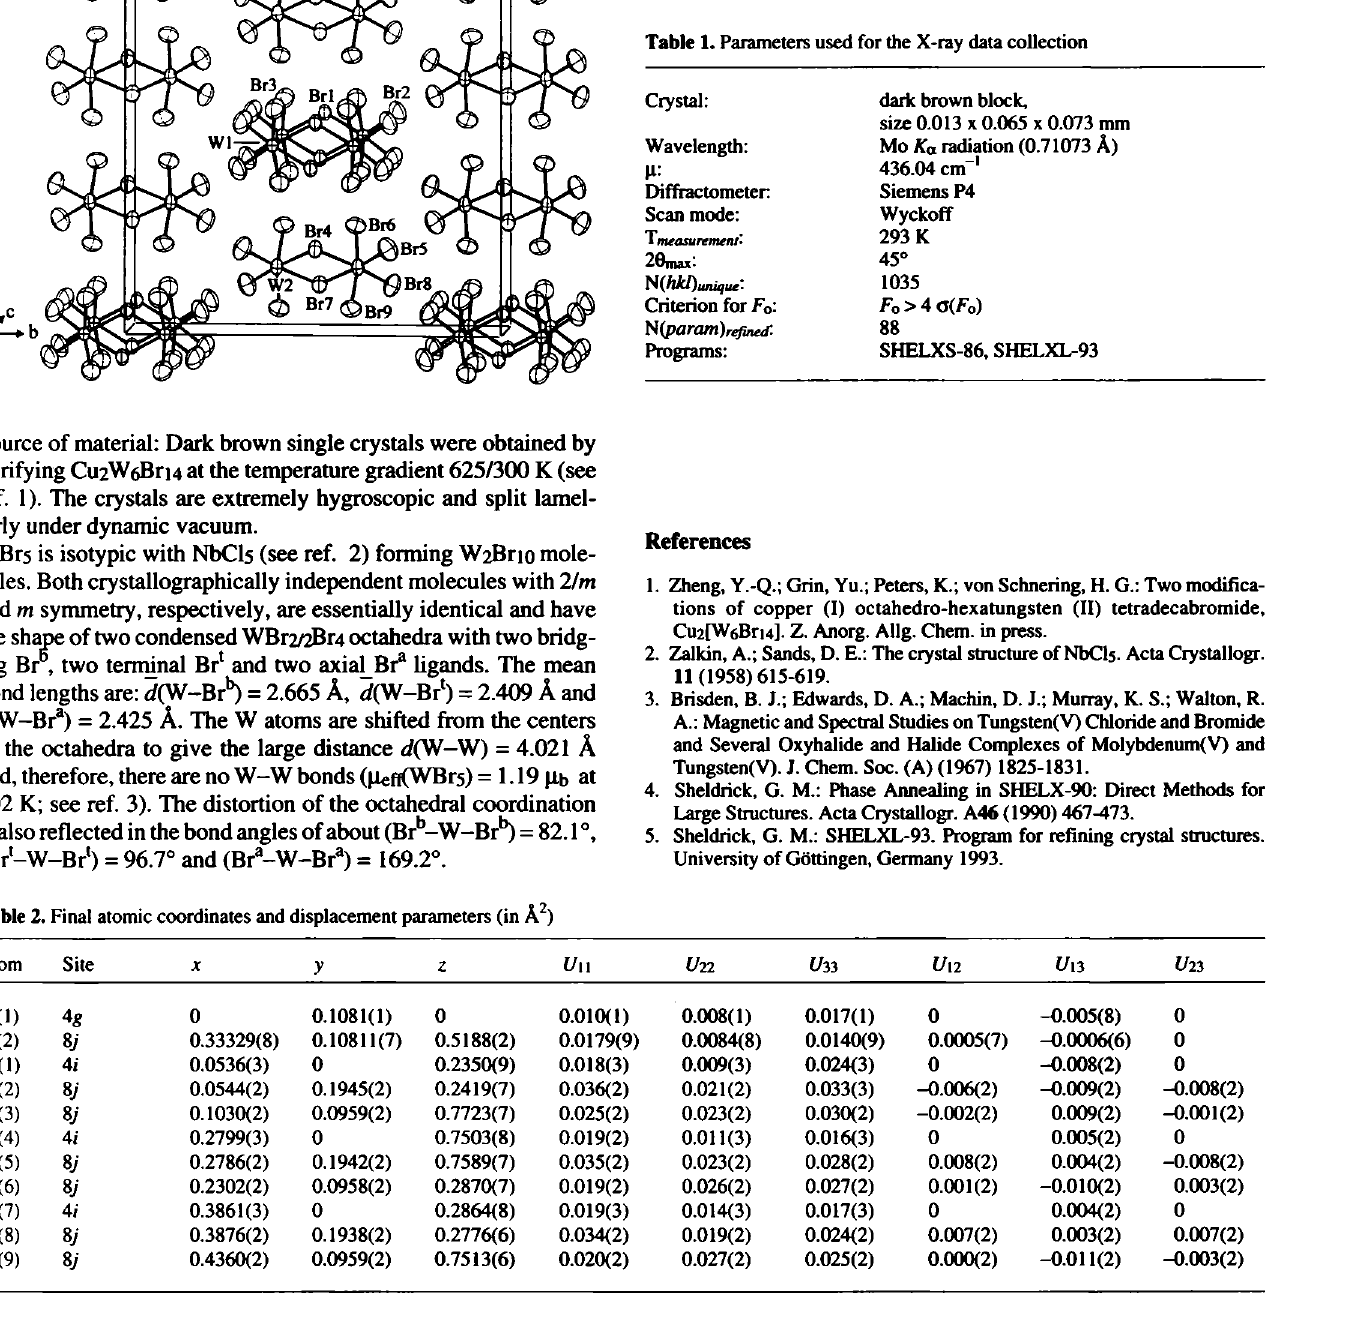
Table 1. Parameters used for the X-ray data collection Crystal: